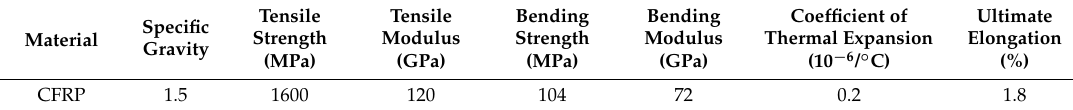
Table 3. Material properties of CFRP.